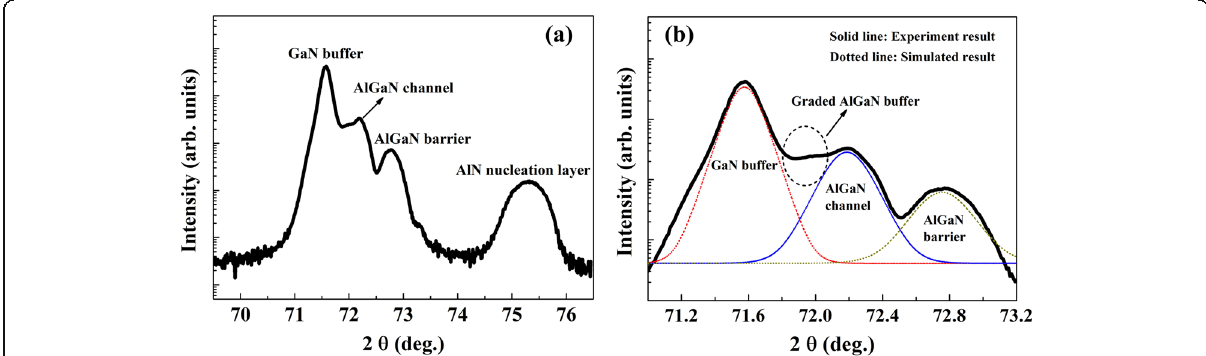
Fig. 3 HRXRD (0004) plane ω -2 θ scan of AlGaN double channel